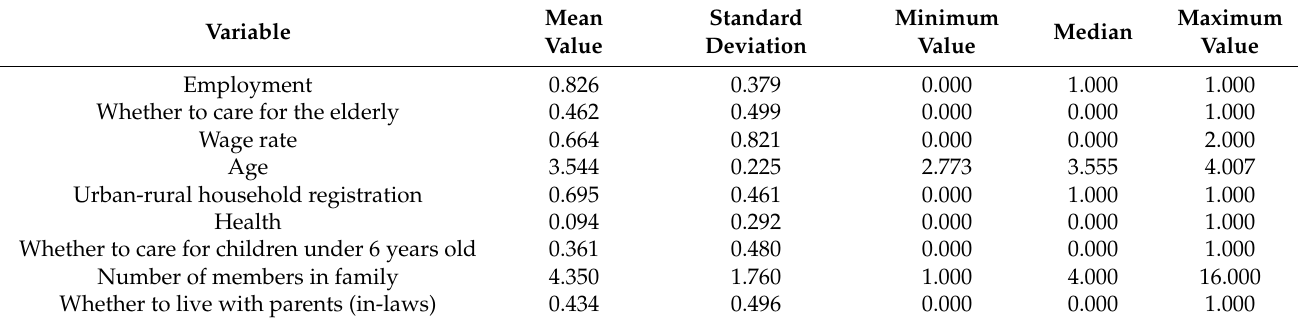
Table 1. Descriptive statistics of the